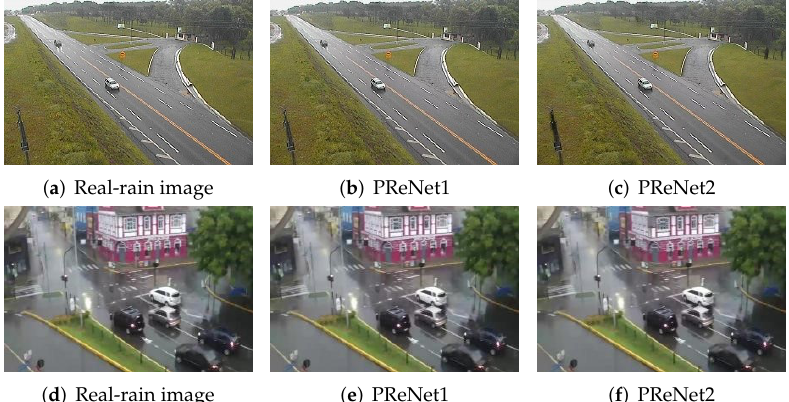
Figure 12. Test result on real-rain image from Real Data . PReNet 1 and PReNet 2 represent the different models trained on the Rain 100 L and the Rain Vehicle Color -24 training subsets, respectively.